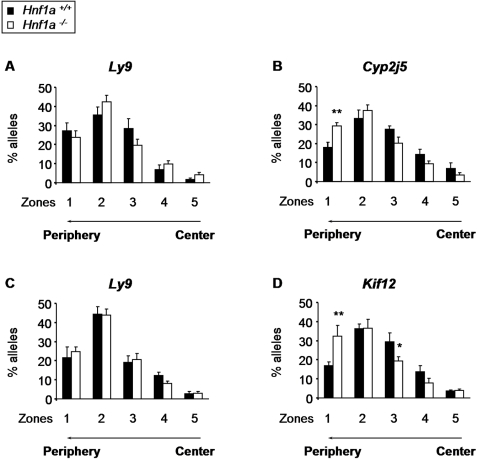
Hnf1α determines the radial nuclear position of its target loci.DNA-FISH erosion analysis of the radial positioning of the Ly9 control locus (A,C) and the Hnf1α-dependent loci Cyp2j5 (B) and Kif12 (D) in Hnf1a+/+ (black bars) and Hnf1a−/− (white bars) hepatocytes (A,B) and islet-cells (C,D). The nucleus was divided in 5 concentric zones and the percentage of FISH signals present in each zone was determined for each locus and genotype. The graph depicts the mean±SEM. *p<0.05 and **p<0.01 relative to Hnf1a+/+ cells.